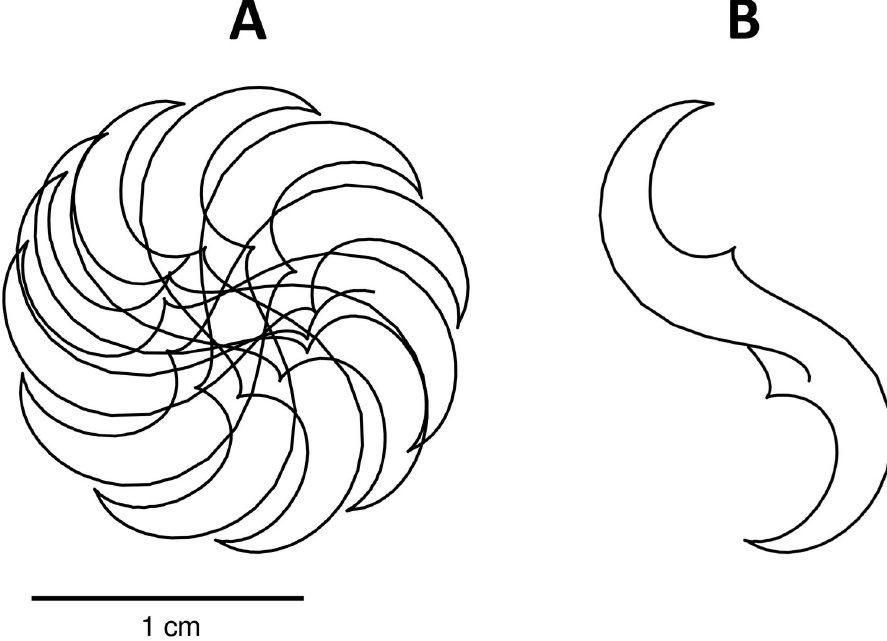
Fig 6. Spiral tip trajectory during reentry dynamics. (A) Spiral tip trajectory over 1.5 s of simulation after 2.5 s the S2 stimulus. (B) Spiral tip trajectory over a single full rotation.